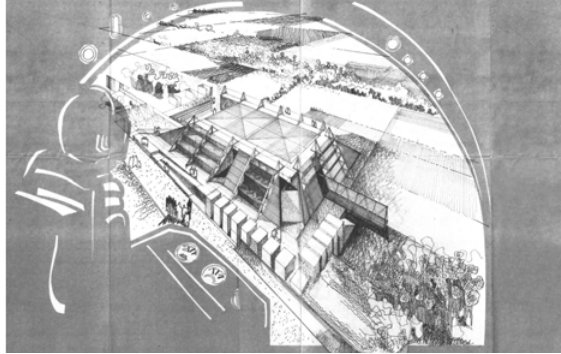
Figure 1 . Perspective of the first project of what was initially a covered market drawn up by prof. Leoncilli Massi in 1972.